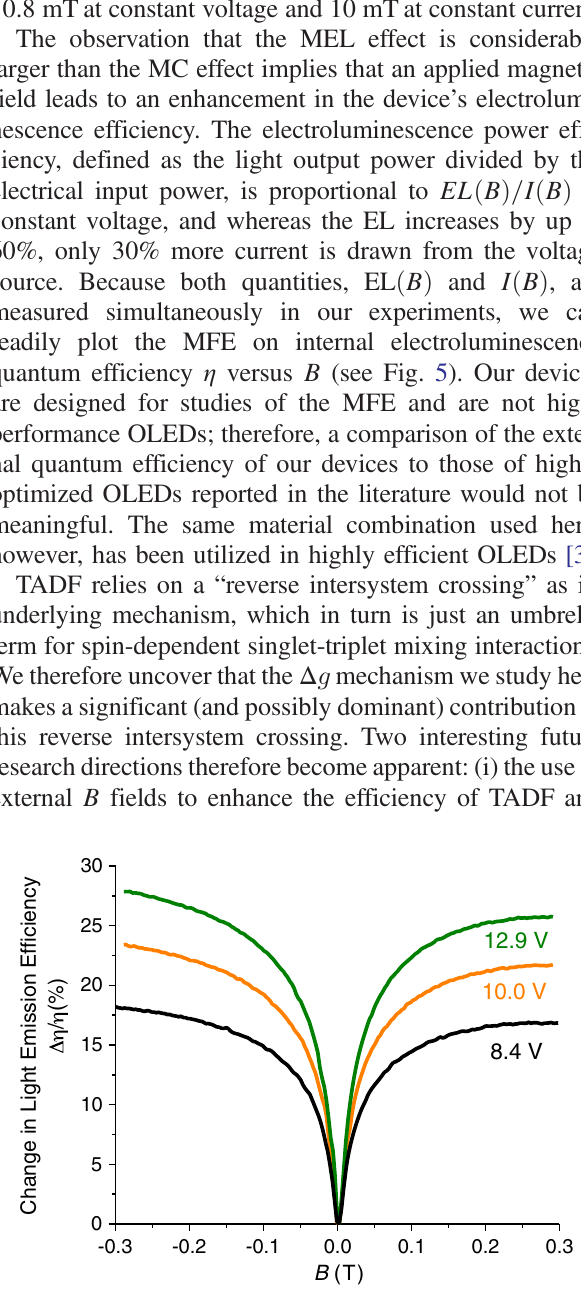
FIG. 5. Magnetic-field effect on electroluminescence efficiency η in the pristine device for three representative constant voltages. The curves shown here are for the same device and experimental data set as in Figs. 4(a) and